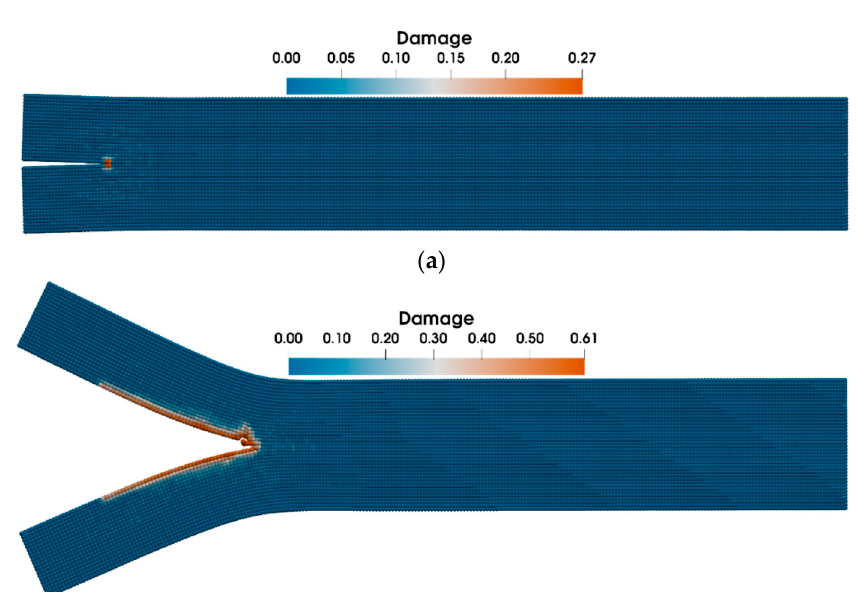
Figure 7. A single edge notch (SEN) specimen at: ( a ) 3,099,999 cycles; ( b ) 13,275,999 cycles. Displacements are increased 10 times.